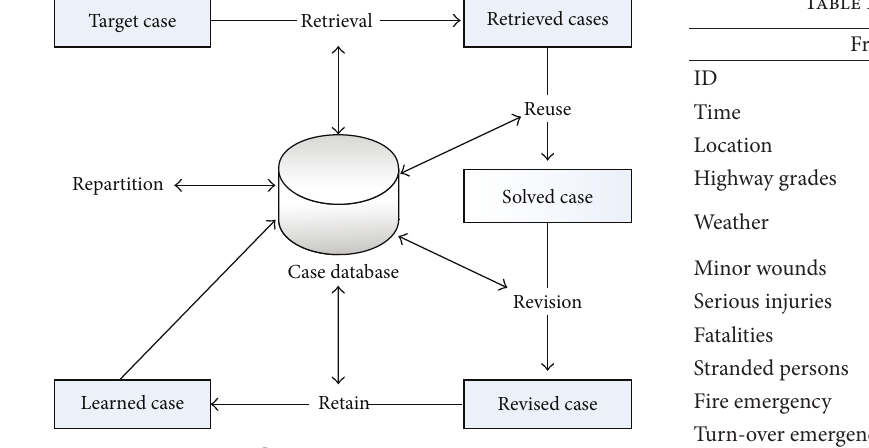
Figure 1: The 𝑅 5 model of Case-Based Reasoning.